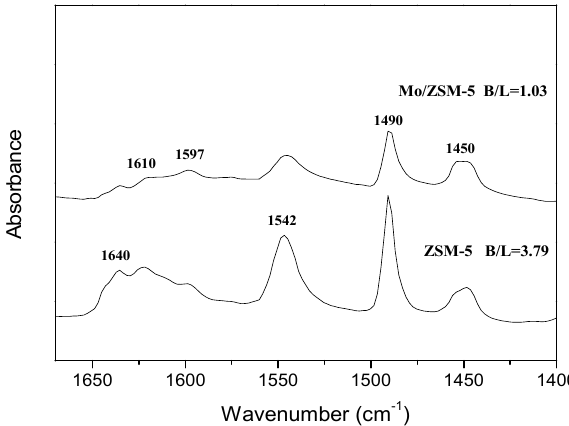
Figure 3. Pyridine infrared spectroscopy (Py-IR) of the ZSM-5 and Mo/ZSM-5 catalysts.